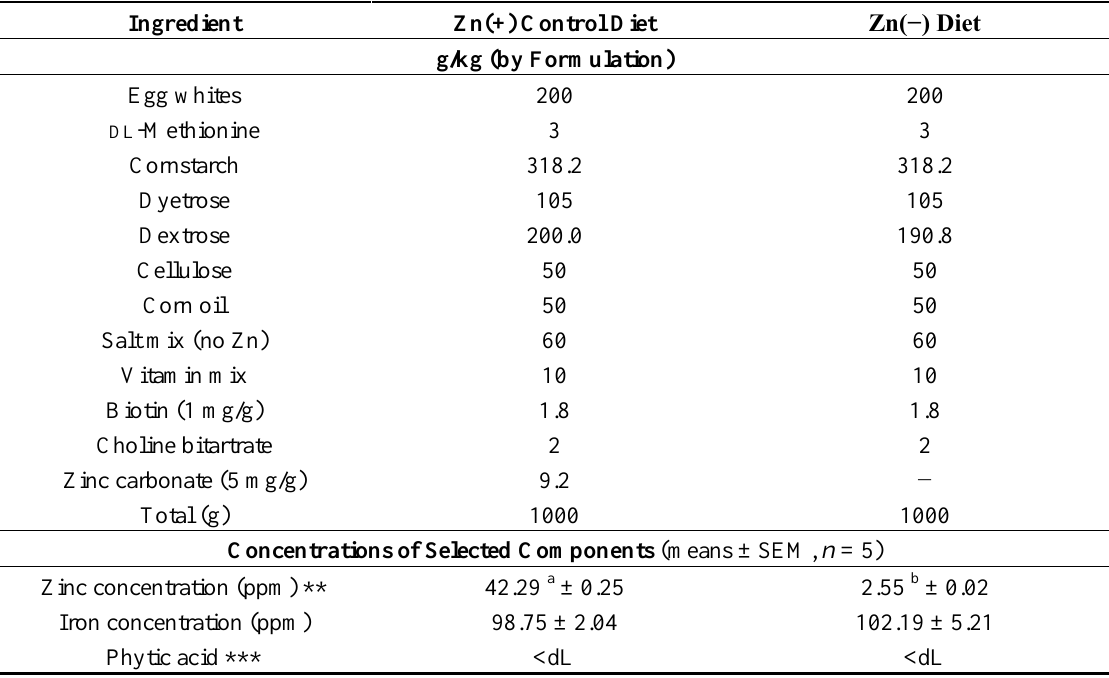
Table 1. Composition of the experimental diets *. Ingredient Zn(+) Control Diet Egg whites